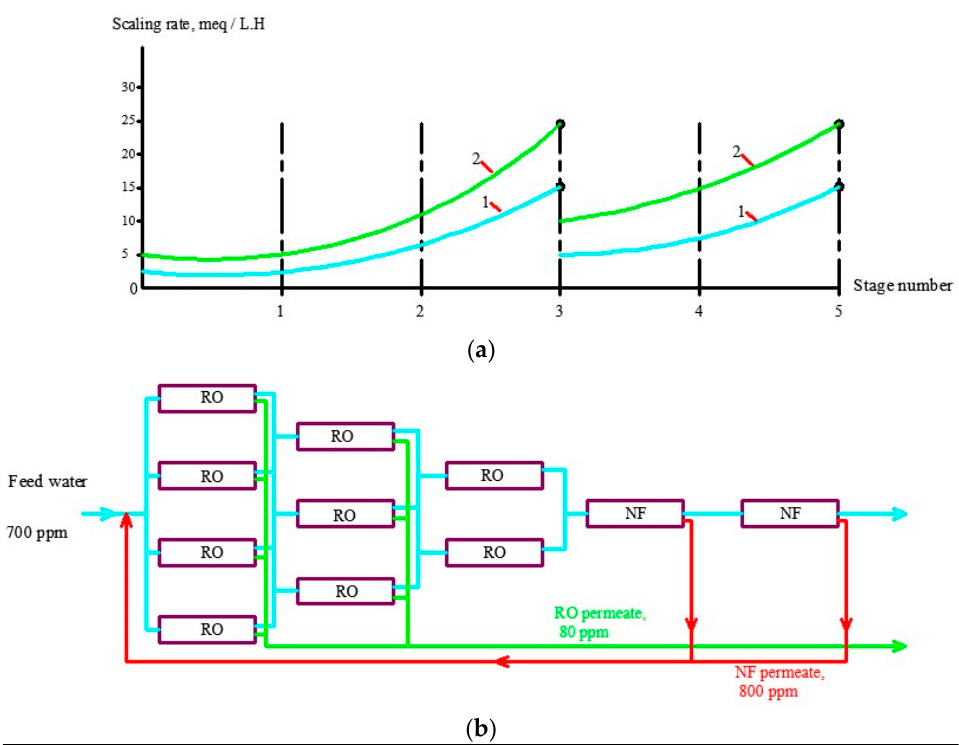
Figure 10. Evaluation of calcium carbonate scaling rates in membrane elements of the RO plant array: ( a ) dependencies of scaling rates on the membrane stage number; ( b ) pressure vessels array in membrane plant; 1—Jurby-Soft, 5 ppm; 2—Aminat-K, 2 ppm.